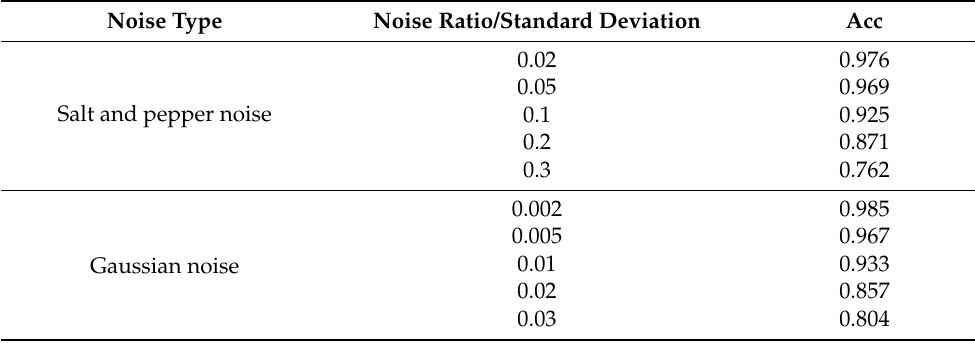
Table 7. Comparison of the final classification effect of adding noise to the data set.